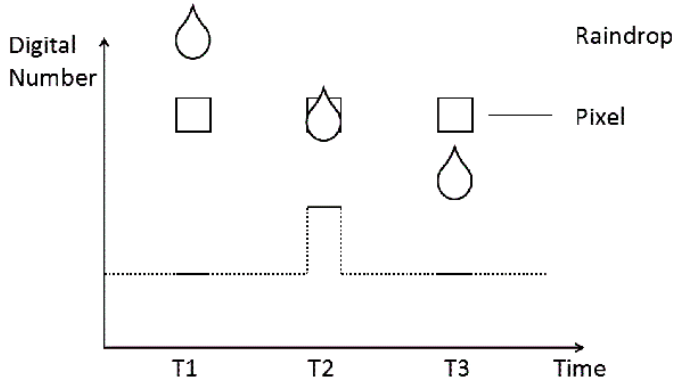
Figure 2. Change of raindrop coverage pixels.